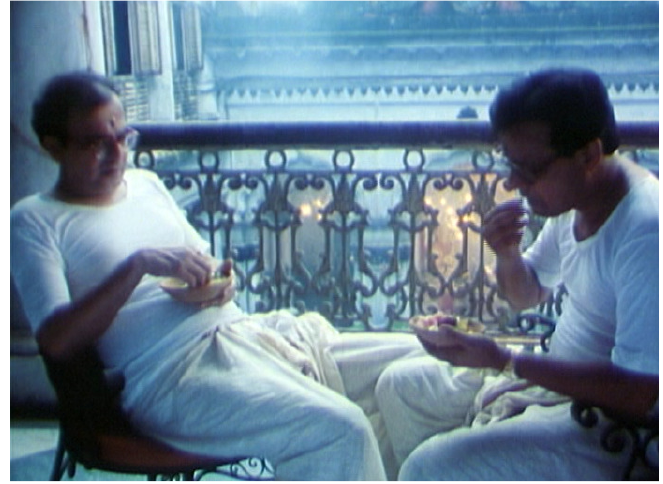
Figure 12. Bhagabati’s sons on the balcony, Durga puja in the background, screen grab, Utsab